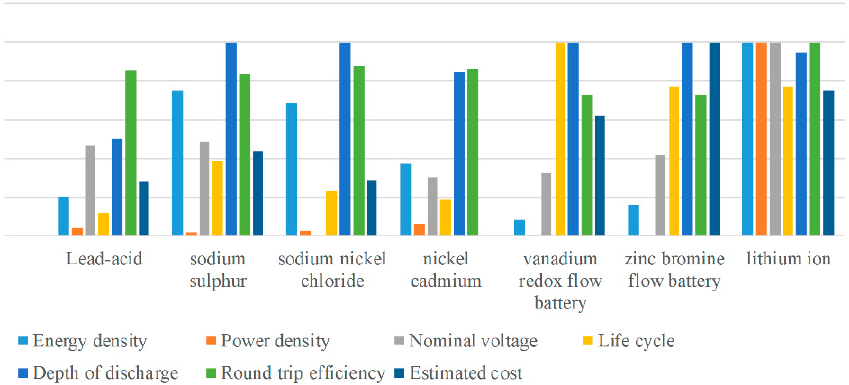
Figure 1. Comparison of different battery storage systems [14,15].